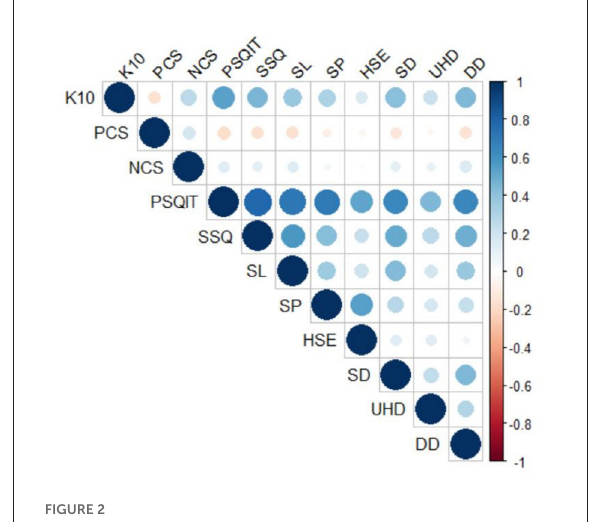
FIGURE2 Heat map of the relationship between sleep quality and its various dimensions, coping styles and psychological distress among psychiatric nurses ( n = 812, Shandong,